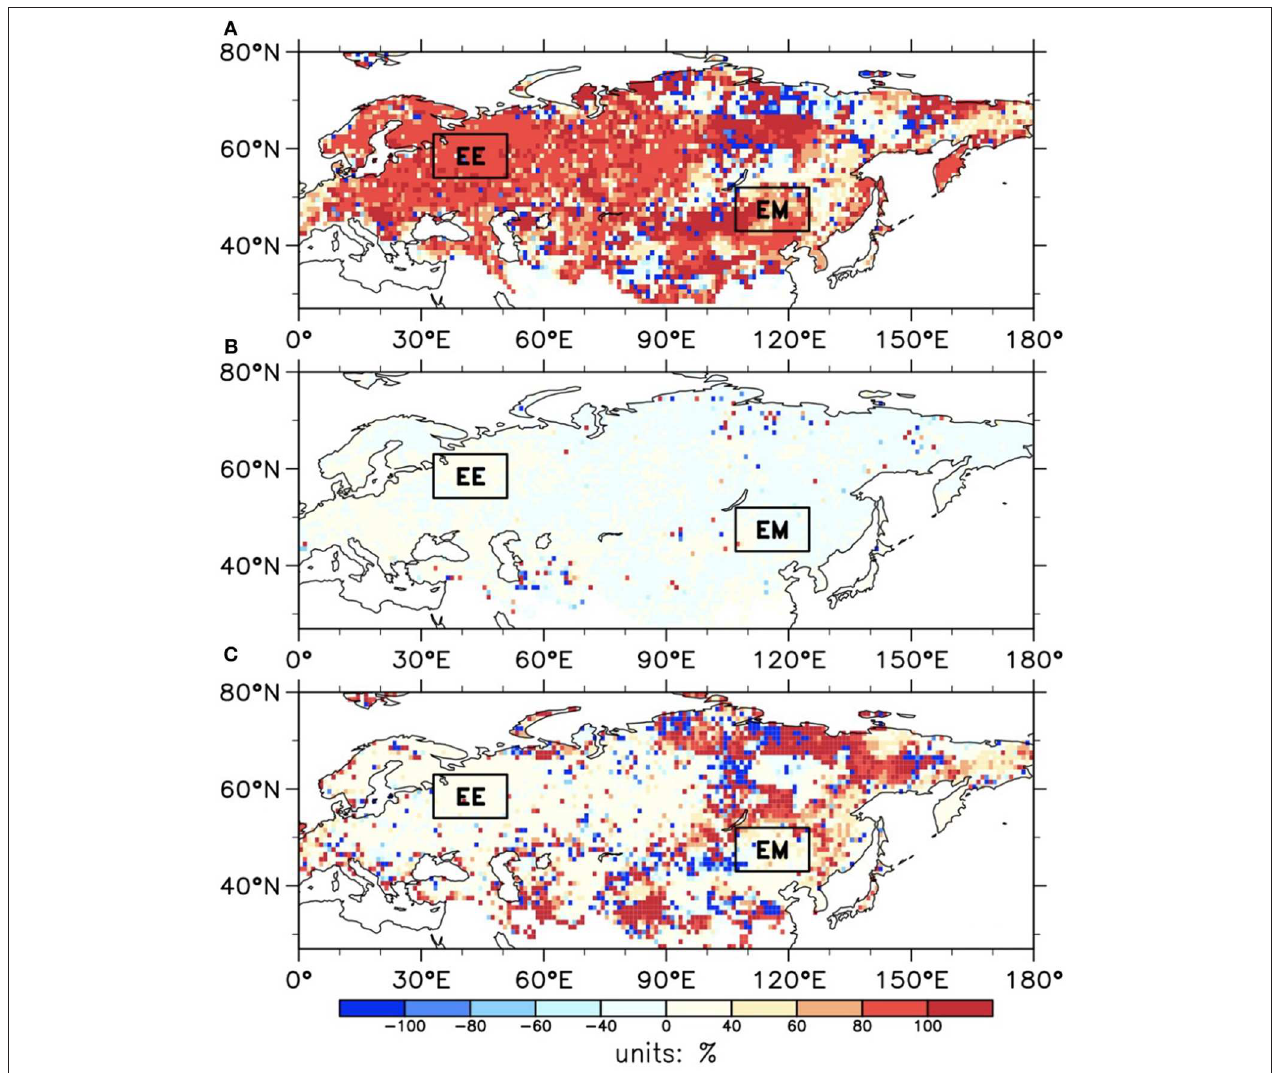
FIGURE 7 | The relative contributions of (A) soil ice, (B) soil liquid water, and (C) soil temperature to soil enthalpy trends at mid-high